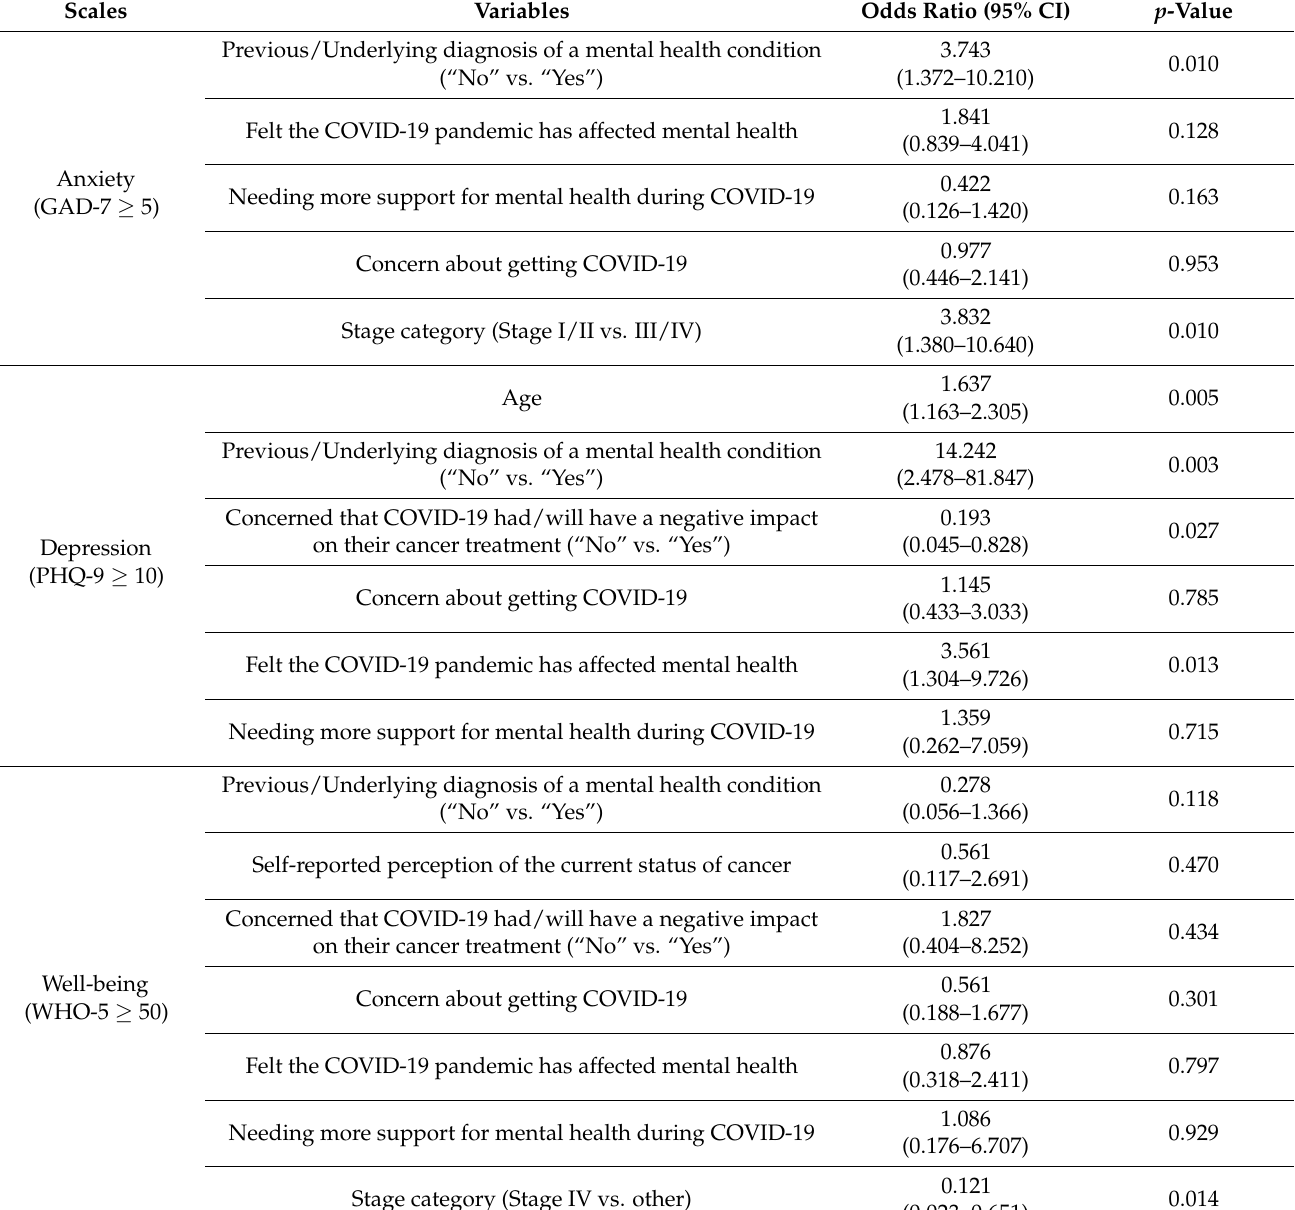
Table 3. Multivariable analysis of variables tested associated with GAD-7, PHQ-9, and WHO-5. Scales Variables Odds Ratio (95% CI) p